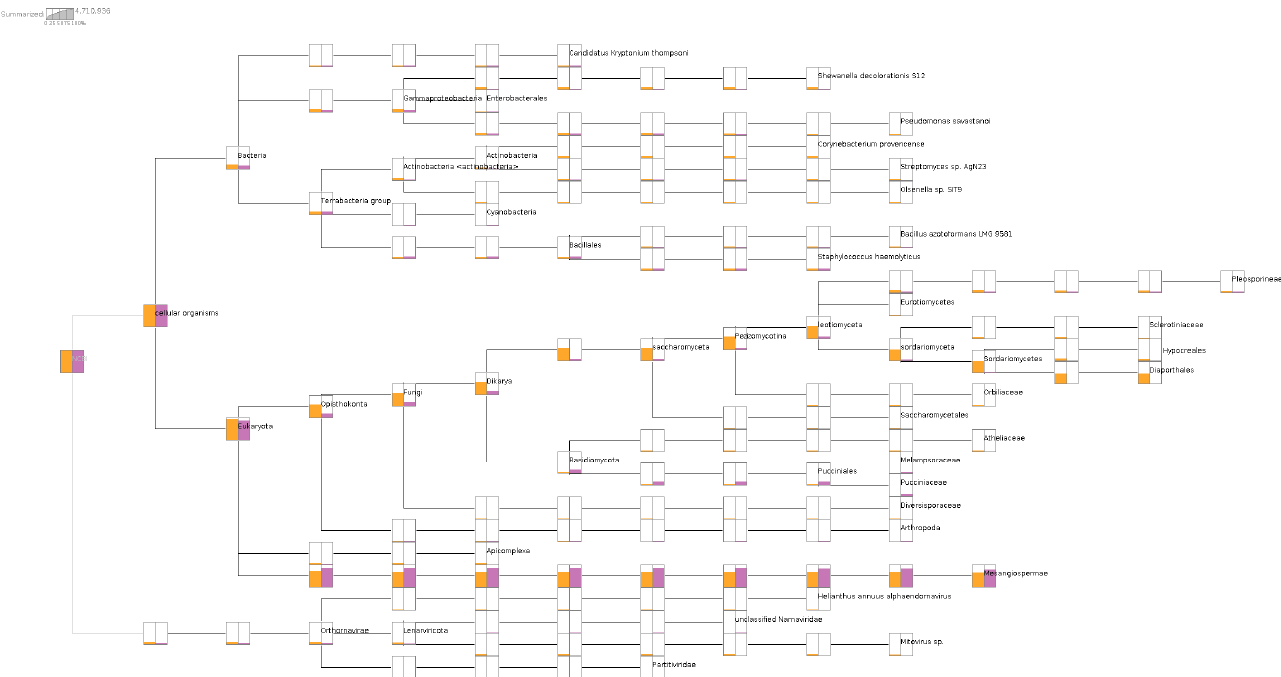
Figure 1. Metatranscriptomic comparison of two libraries showing the microbiome/virome composition in libraries SF1 and SF2. Both libraries contained more than 60% of sunflower transcripts under Mesangiospermae clade. Only library SF1, labeled in orange, had reads from Diaporthales for phomopsis disease, whereas only library SF2 contained reads from Pucciniaceae for rust disease.